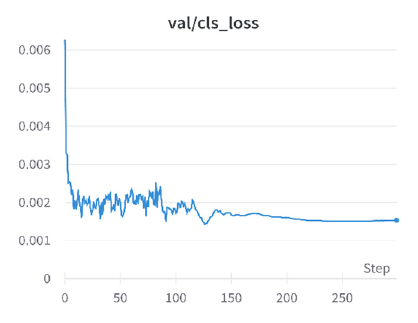
Figure 5. Validation dataset classification loss.